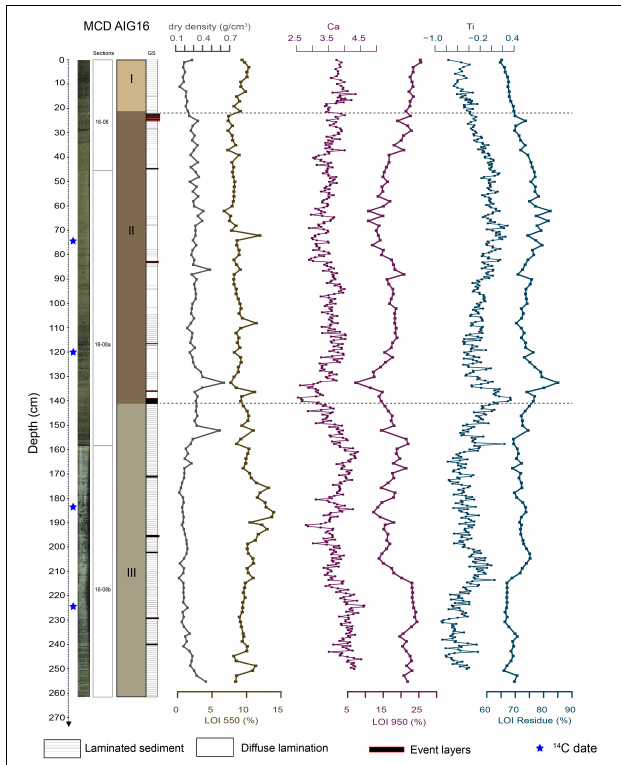
FIGURE 2 | Sedimentological description of AIG16-MC including photography, lithological facies and units, dry density measurements, LOI analyses and selected XRF core scanner elements (centred-log ratios) reflecting the minerogenic fraction (Ti as proxy for the non-carbonated detrital compounds and Ca for the carbonated